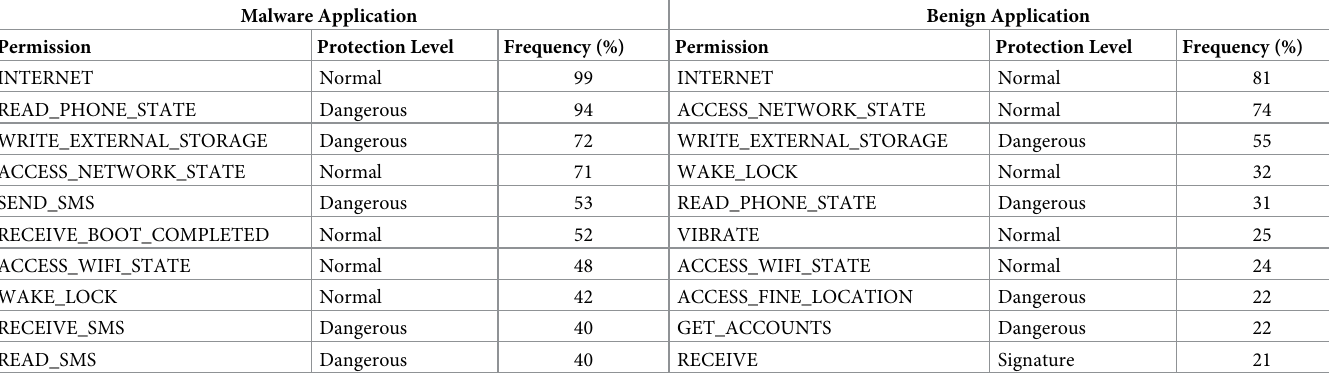
Table 4. 10 most frequent permission requests in malware and benign applications.